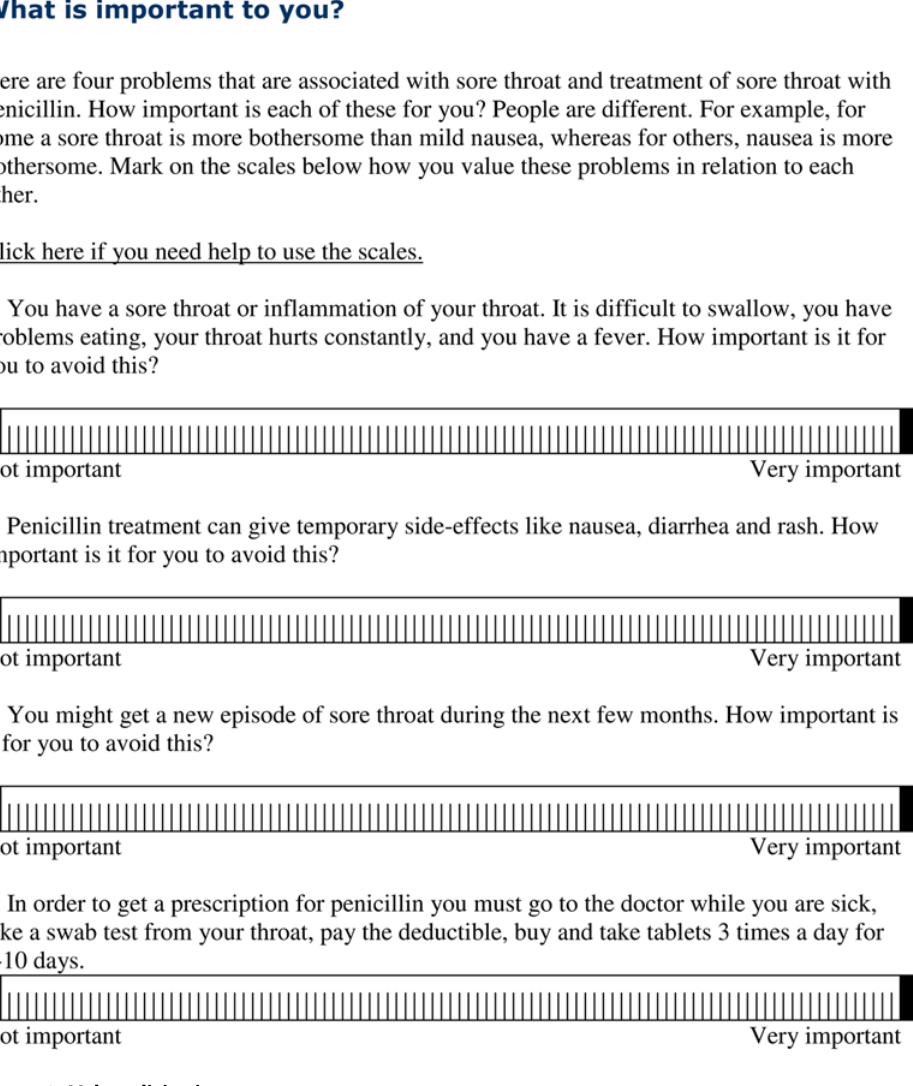
Figure 2. Value elicitation.